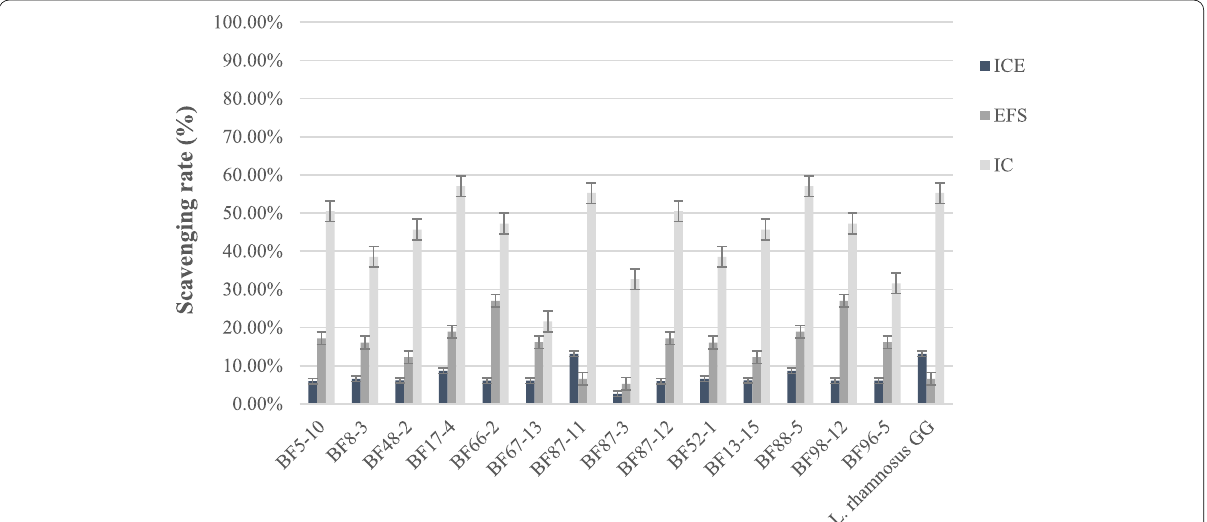
Fig. 5 The ability of the Bifidobacterium strains’ intracellular cell extract (ICE), extracellular fermentation supernatant (EFS), and intact cells (IC) to scavenge hydroxyl free radicals. (Error bars indicate standard deviation from three independent experiments)